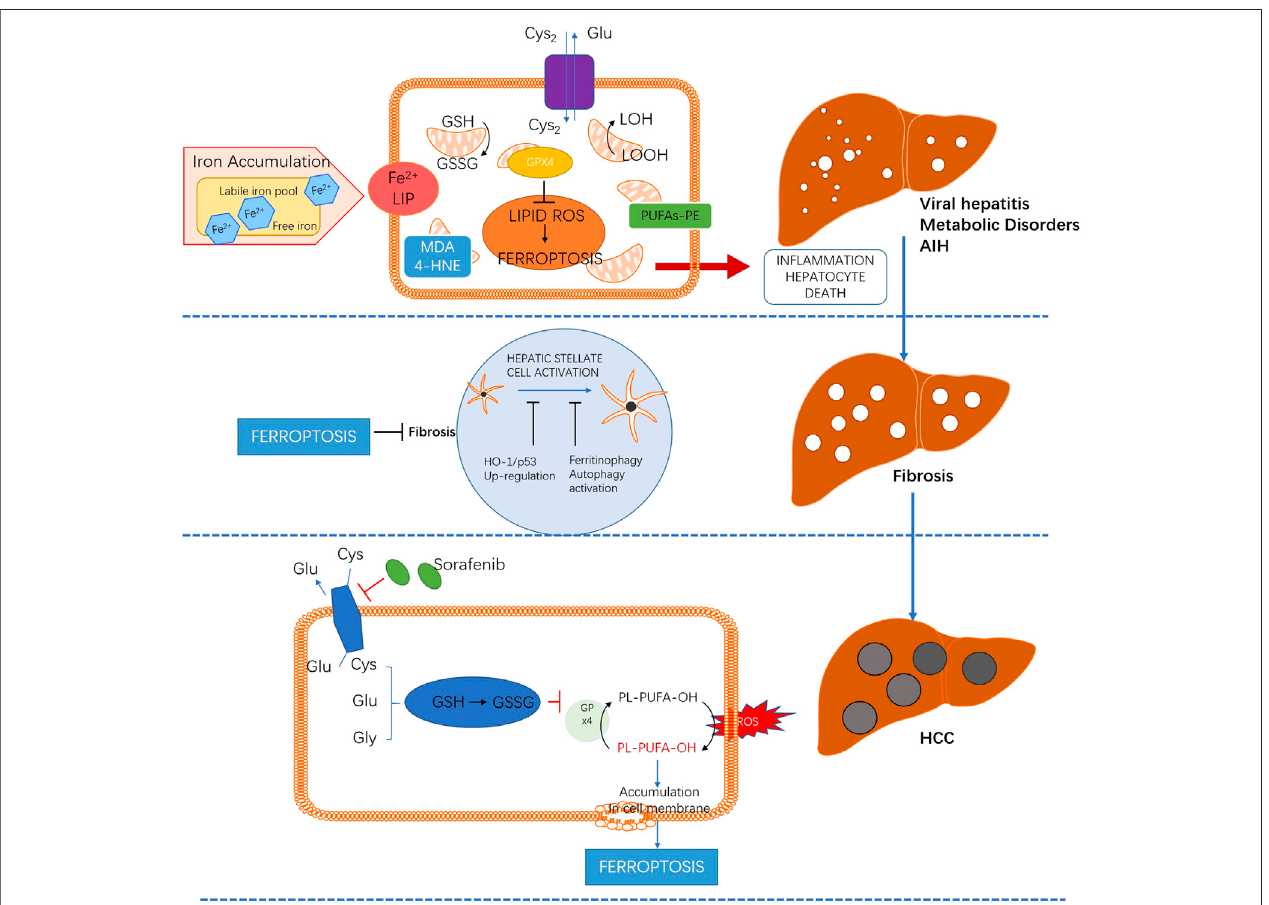
FIGURE 2 | The role and potential mechanism of ferroptosis in different liver diseases.